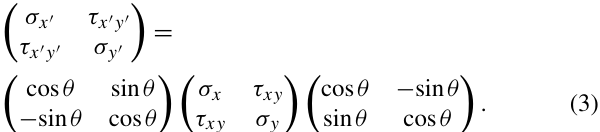
Figure 4. Shear stress changes within the fault during fault reacti-